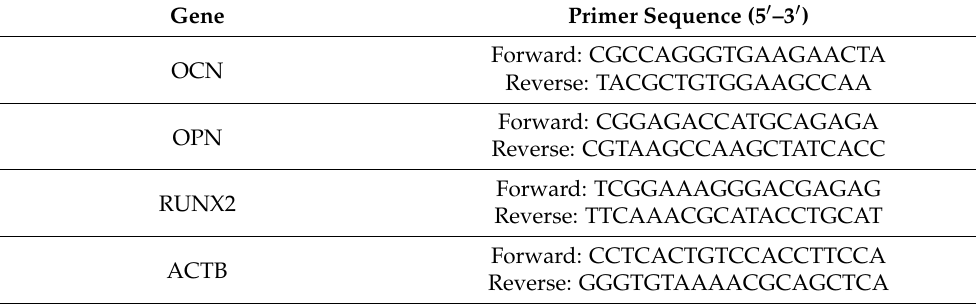
Table 1. Primer sequences.